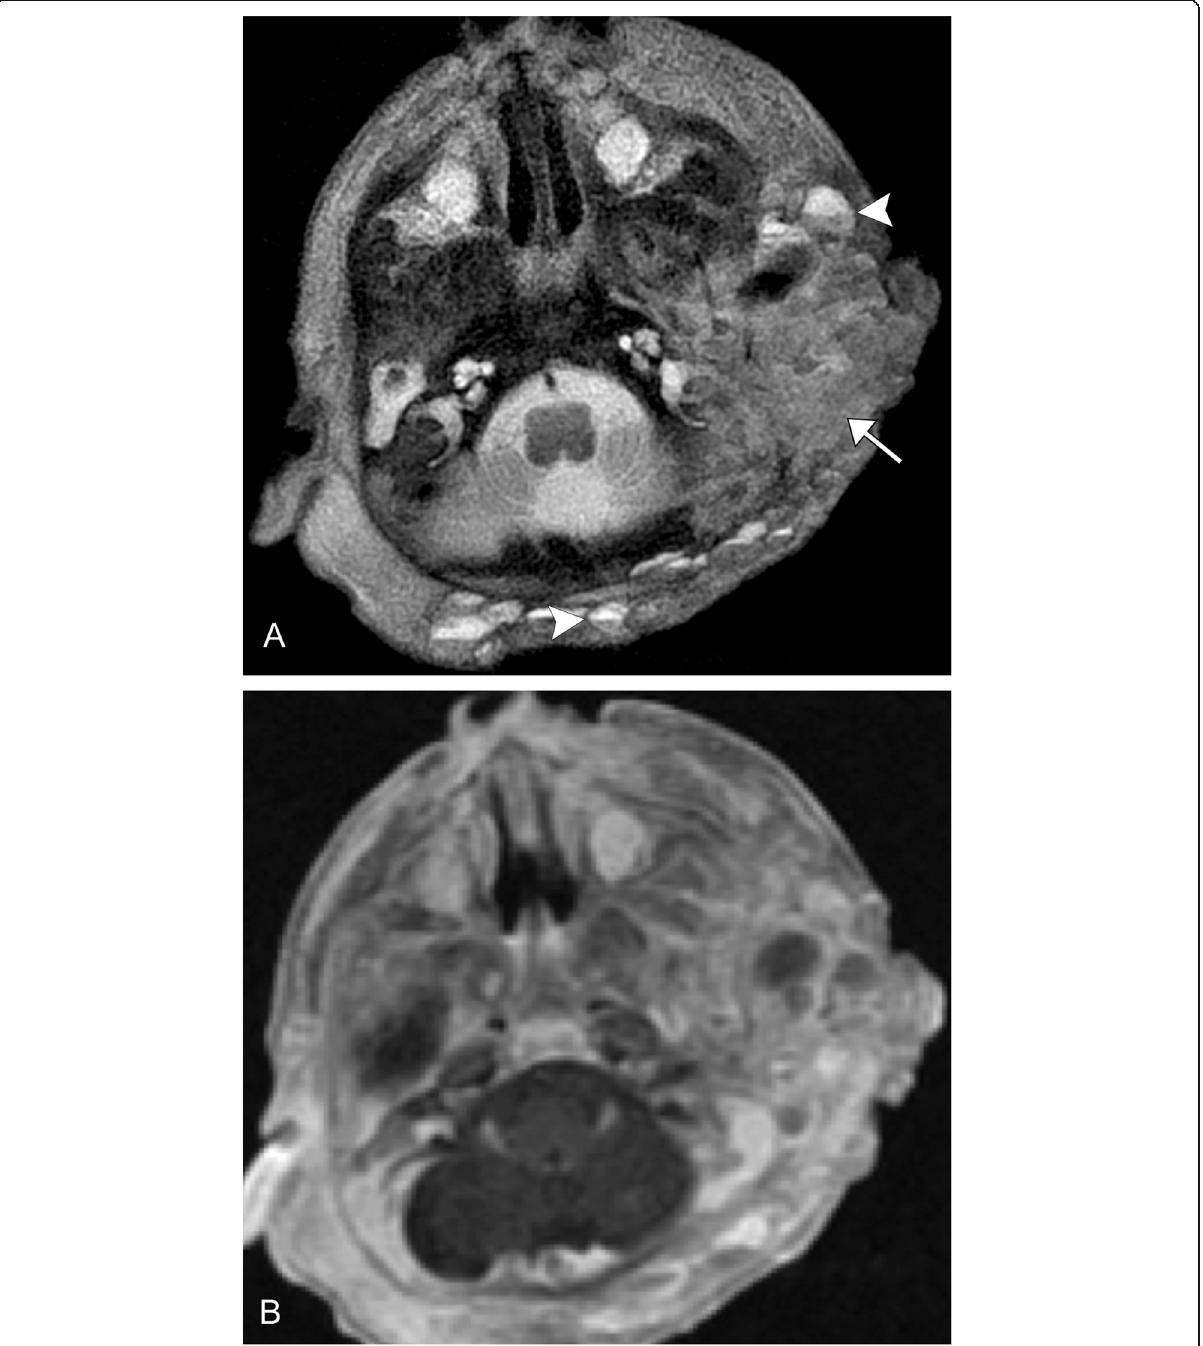
Fig. 4 Kaposiform hemangioendothelioma. A 2-week-old premature male with large left neck mass. a Axial T2 image demonstrates an infiltrative, transpatial left facial heterogeneous mass that is predominantly mildly T2 hyperintense (arrow), and has multiple fluid-fluid levels (arrowheads). b Axial post-contrast fat-suppressed image demonstrates heterogeneous